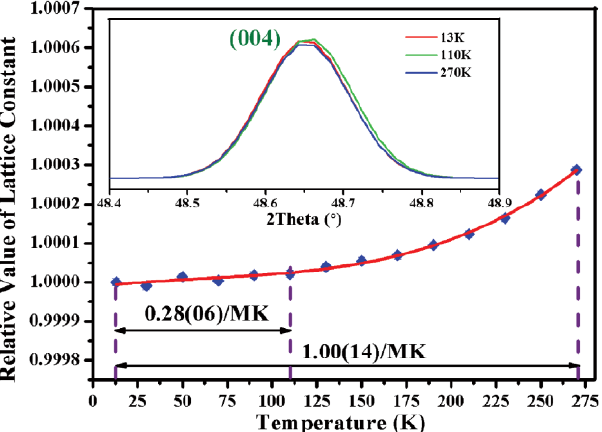
Figure 15. Variation of the refined cell parameters of Zn 4 B 6 O 13 with respect to temperature. Reprinted from Ref. [67], with permission of John Wiley and Sons.